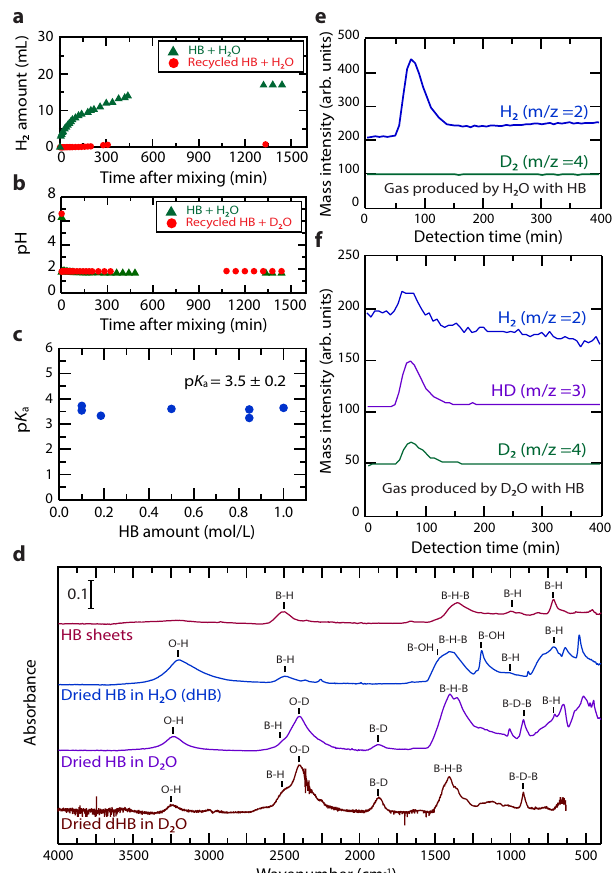
Fig. 2 Proton exchange reaction and hydrolysis reaction of HB and recycled HB sheets in water. a H 2 amount as a function of time for the mixture of H 2 O (2.0 mL) and HB sheets (100 mg) and that for the recycled HB (HB dried at 353 K after 1440 min from the mixture with H 2 O). b pH change as a function of time for the mixture of H 2 O (2.0 mL) and HB sheets (100 mg) and that for D 2 O and the recycled HB (HB dried at 353 K after 1440 min from the mixture with H 2 O). c p K a derived from the pH change after mixing water and HB sheets with various HB amount. d Fourier transform infrared absorption spectroscopy results for the HB sheets, the recycled HB sheets obtained by drying the mixture of HB and H 2 O after 1440 min after mixing (dHB), recycled HB obtained by drying HB in D 2 O after 1440 min after mixing, and recycled dHB obtained by drying the mixture of dHB and D 2 O after 1440 min after mixing. The assignment of the absorption peaks was based on the previous report 21 . e Mass analysis of produced gas after the mixing H 2 O and HB sheets. m/z denotes the mass- to-charge ratio. f Mass analysis of produced gas after the mixture of D 2 O and HB sheets. The horizontal axis in ( e ) and ( f ) indicates time after injection of produced gas in the